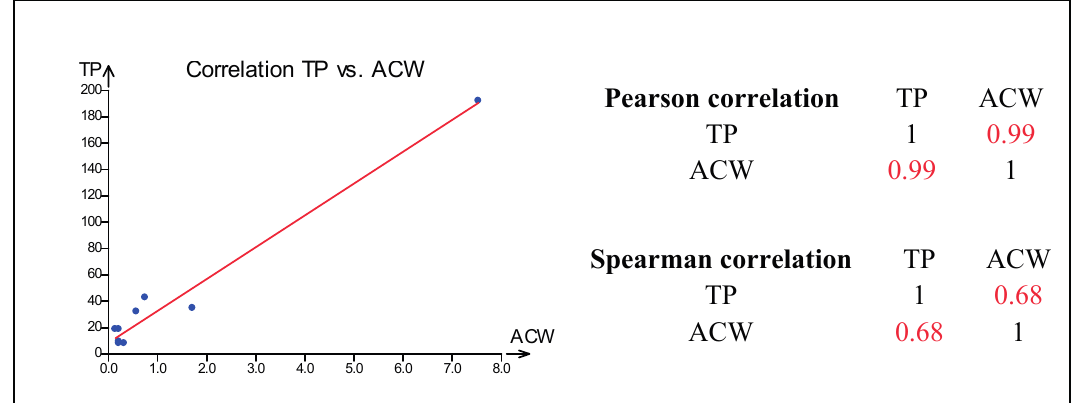
Figure 2. Graphic illustration of correlation between antioxidant capacities of the water soluble compounds (ACW) and total phenolic contents (TP) in algal food products together with matrixes of Pearson and Spearman correlation coefficients. The level of probability was set to p <